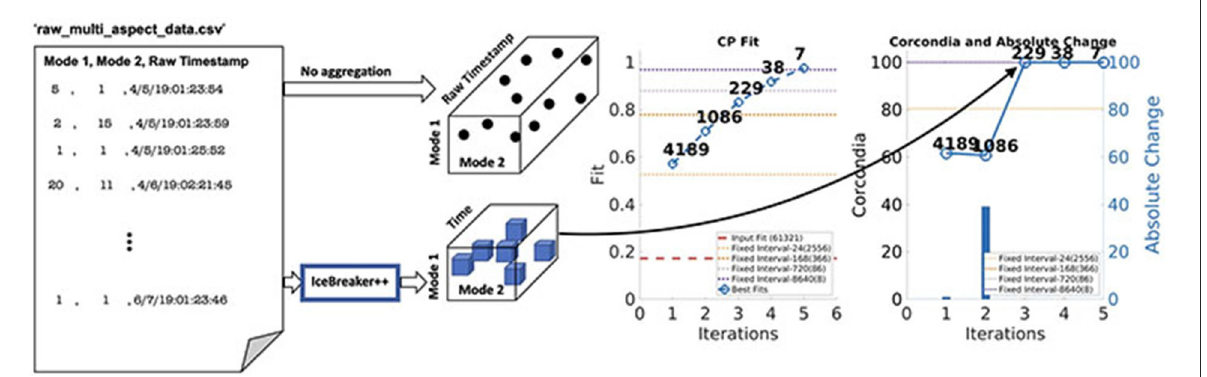
FIGURE1 Starting from raw CSV files, I CE B REAKER ++ discovers a tensor that has a good structure (under various measures of quality, including interpretability and predictive quality), outperforming traditional fixed aggregation heuristics. Furthermore, I CE B REAKER ++ using various notions of locally optimal structure discovers different resolutions in the